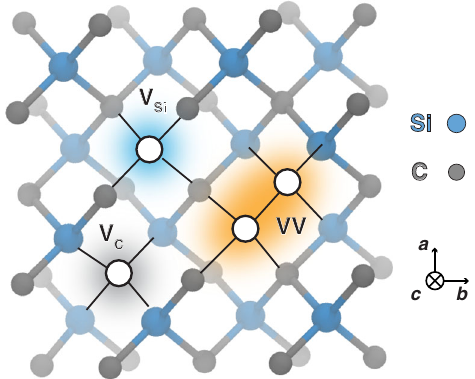
Fig. 1 Ball-and-stick representation of defects in cubic SiC (3C-SiC). A divacancy-defect complex (VV) consists of a carbon vacancy (V C ) paired with a silicon vacancy (V Si ). Carbon and silicon atoms are shown as gray and blue spheres, respectively, whereas vacancies are depicted as white solid